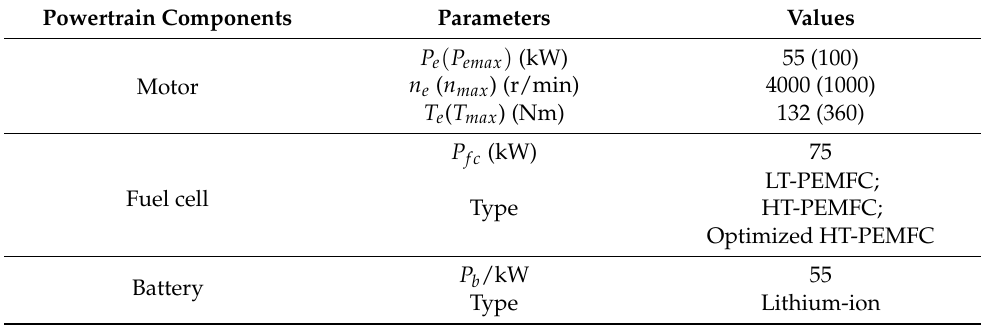
Table 2. The parameters of the FCV powertrain.